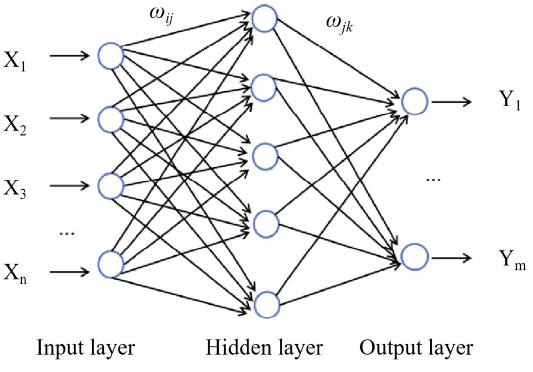
Figure 2. BPNN topology.